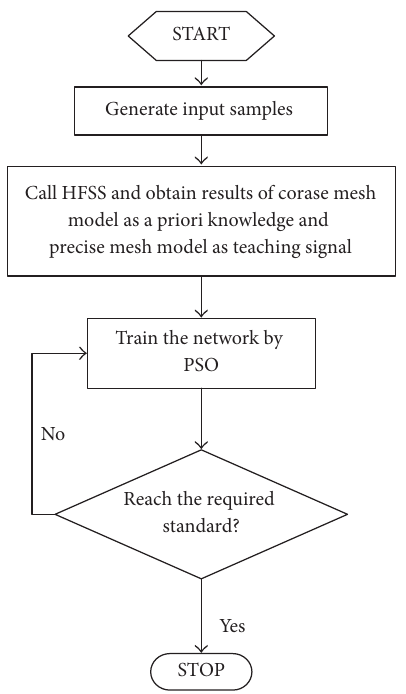
Figure 2: Flowchart of the proposed